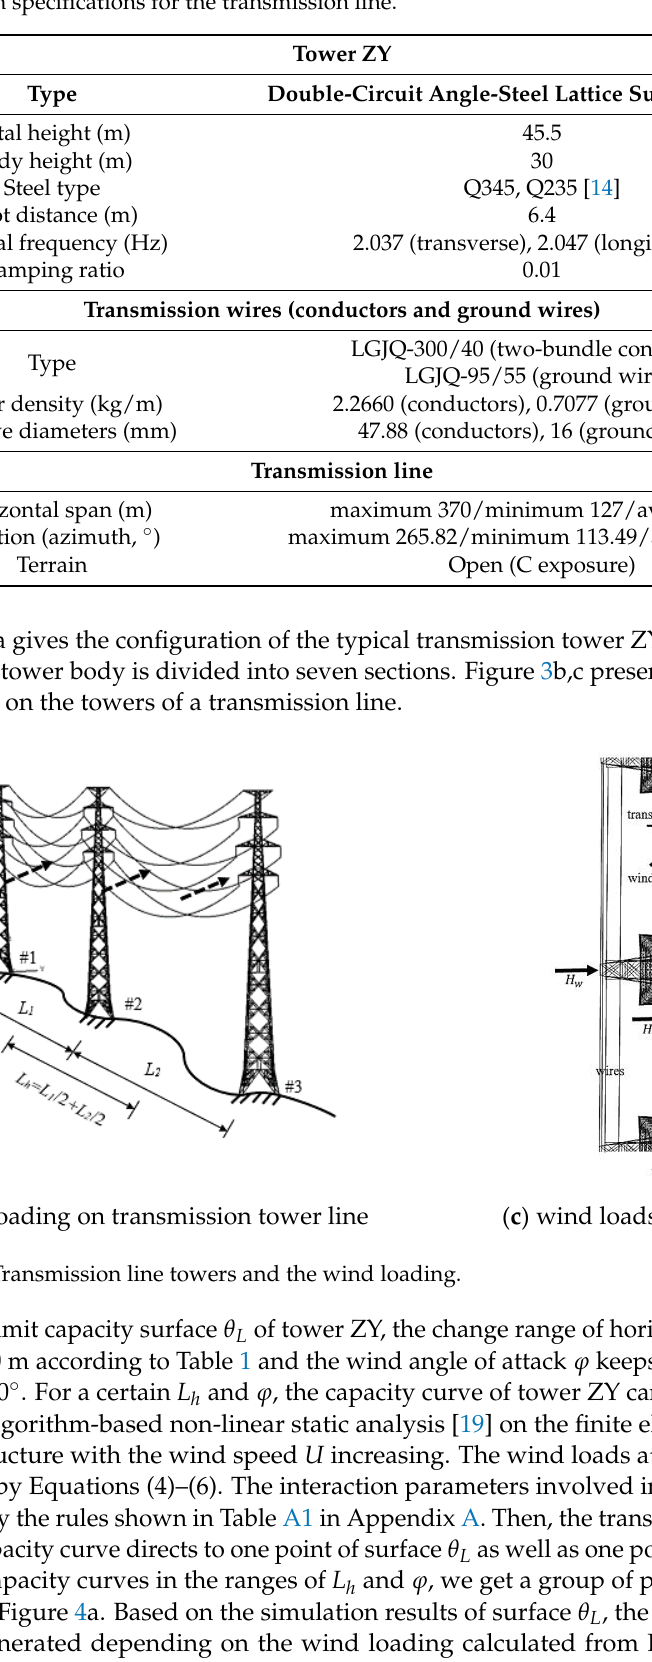
Table 1. Design specifications for the transmission line.